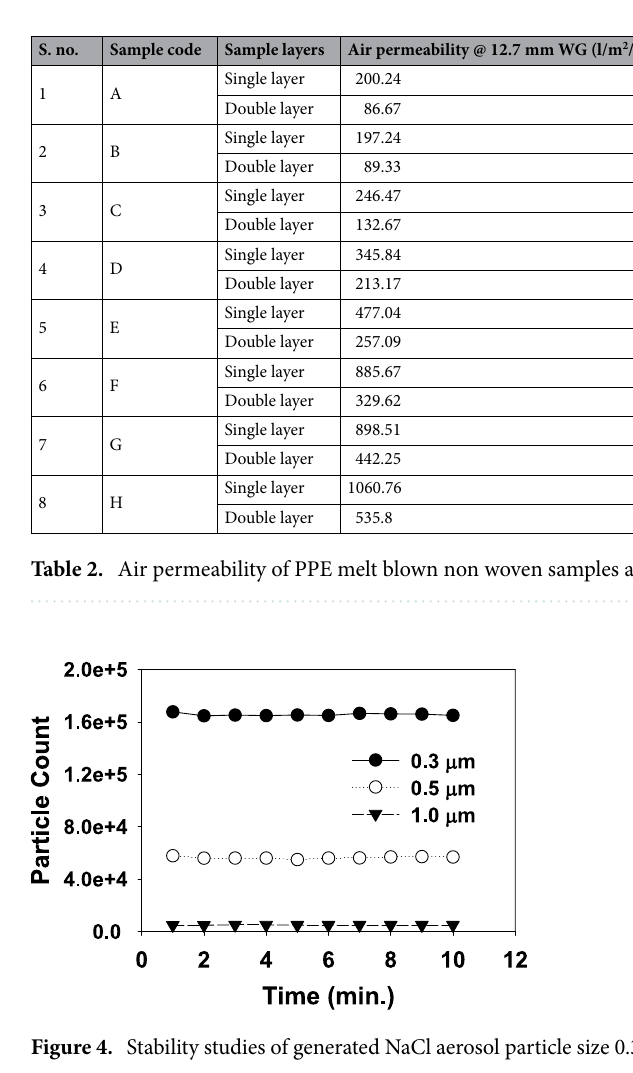
tion. Table 3 details the results obtained with the individual and its combination of PP-MB-NW layer for PFE, Differential Pressure (∆P) and breathing inhalation resistance (BIR). The ∆P and BIR across PP-MB-NW layer was measured to determine the comfort level of wearer and the suitability of materials to fabricate the mask.